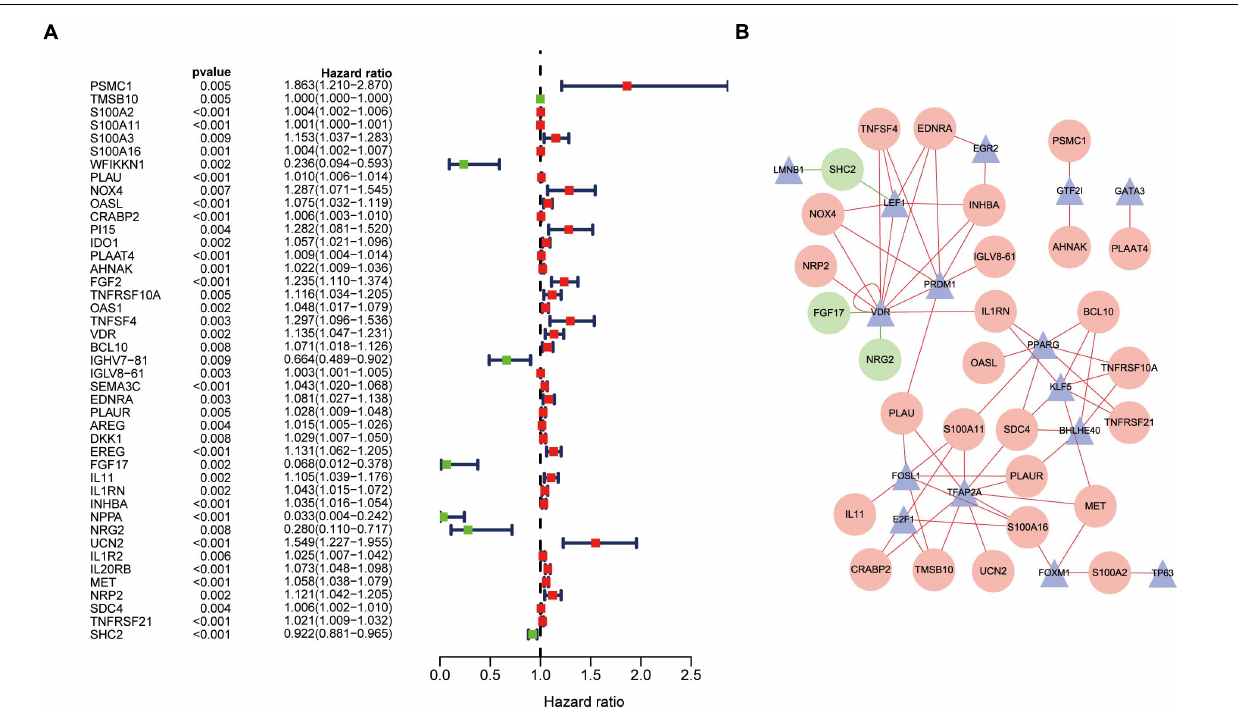
FIGURE 4 | Overall survival (OS)-related DEIRGs and TFs-IRGs regulatory network. (A) The forest plot of OS-related DEIRGs in PAAD. Red and green dots indicate high risk and low risk, respectively. (B) Regulatory network between prognosis-related DEIRGs and DETFs in PAAD. The red and green circles indicate high-risk and low-risk DEIRGs, respectively. The blue triangles indicate DETFs. The red and green lines represent positive and negative correlation,